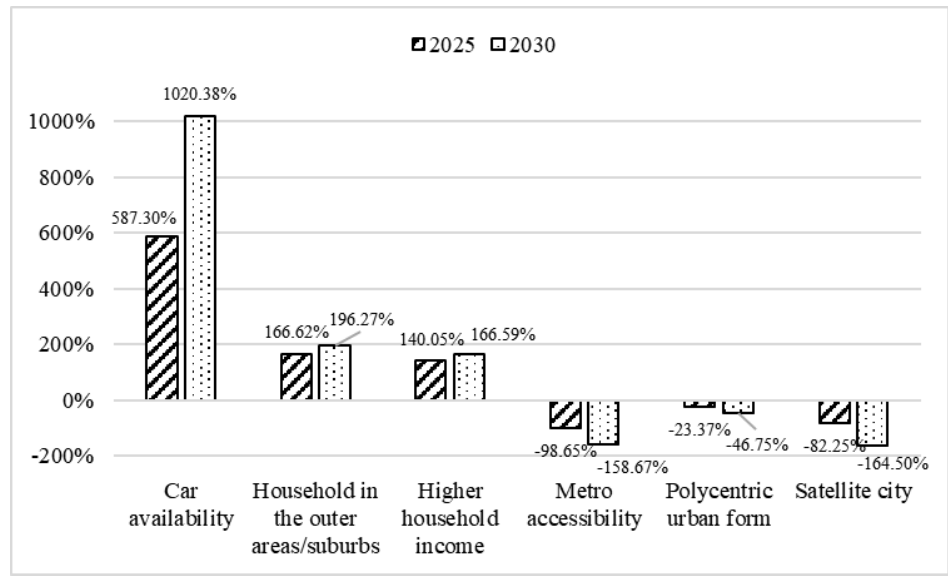
Figure 2. The estimated changing percentages of the individual commuting CO 2 emissions per trip in 2050 and 2030 in developing city of Xi’an.